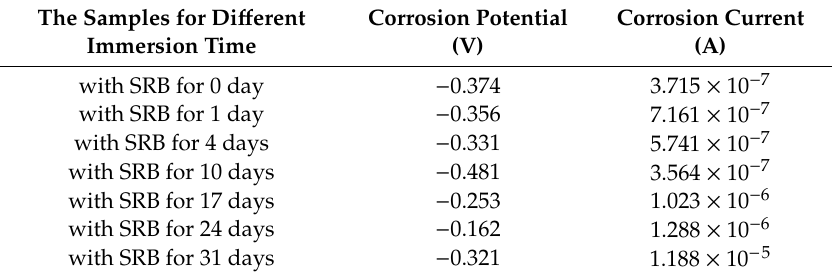
Figure 2. Potentiodynamic polarization curves of the samples for different immersion time. Table 3. Polarization parameters of the samples for different immersion time.